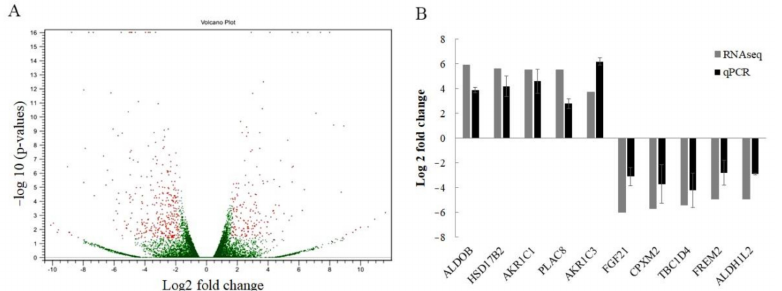
Figure 2. Identification of differentially expressed genes between KATOIII and KATO/DDP cells. ( A ) Volcano diagram of differentially expressed genes between KATO/DDP and KATOIII cell lines, showing 174 upregulated and 345 downregulated genes. ( B ) To validate the differentially expressed genes from RNA sequencing, the expression level of five upregulated and downregulated genes were examined by using qPCR.